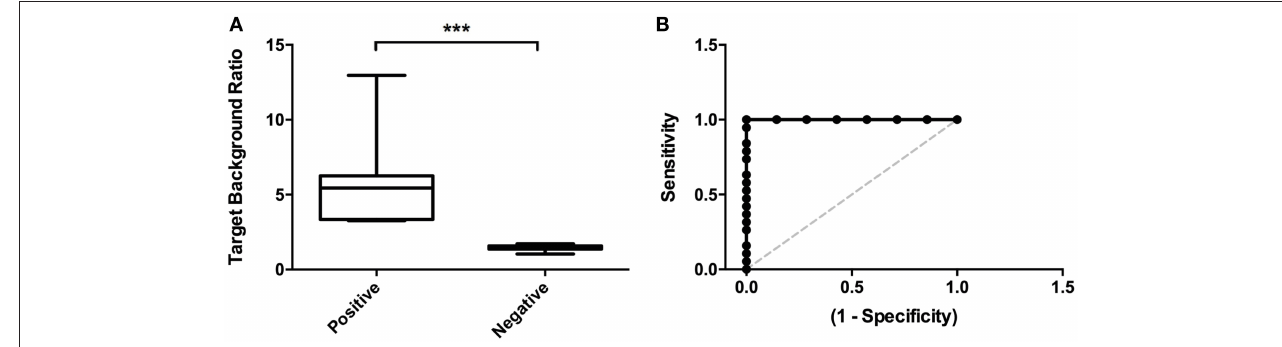
FIGURE 3 | Image analyses. (A) Target Background Ratios were significantly higher in positive scans compared to scans that were visually rated negative. (B) ROC curve analysis detected an optimal cut-off value for TBRs < 0.67 with 94.74% sensitivity and 100% specificity. *** p < 0.001.